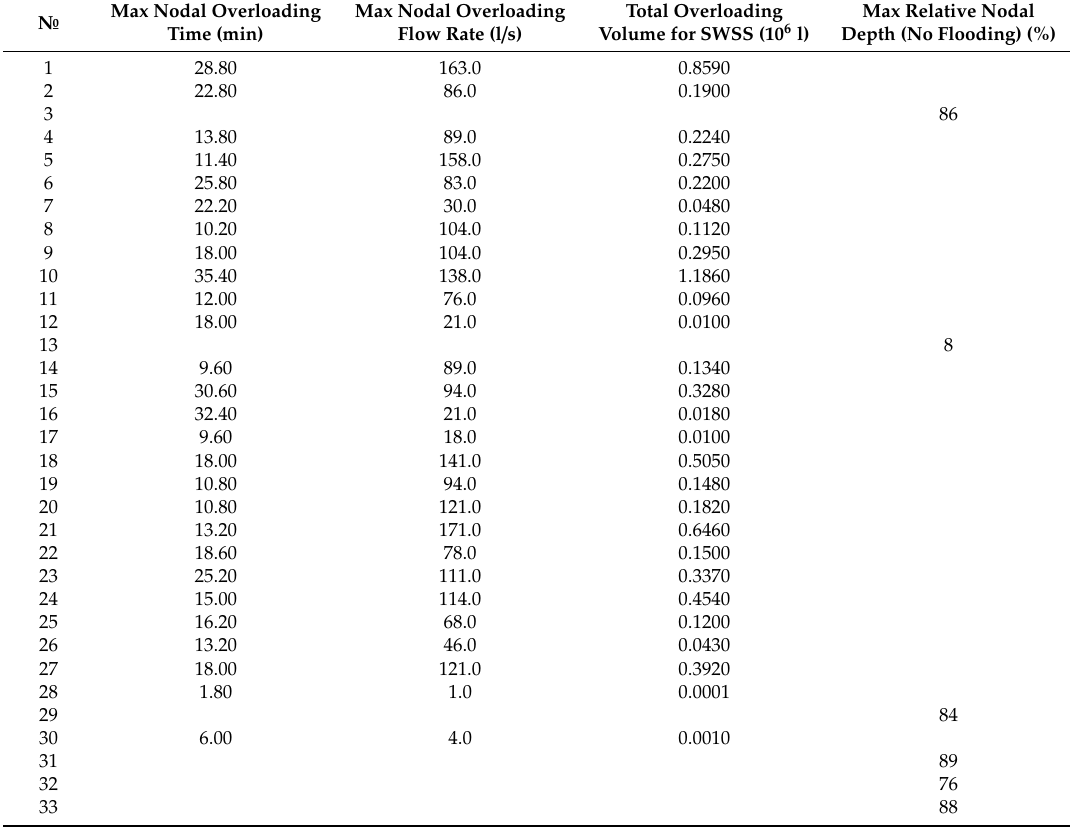
Table A2. Results of the model run with 1 min resolution precipitation